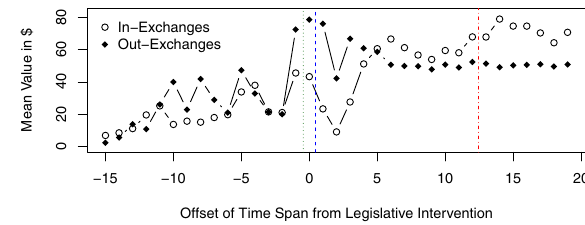
Fig. 11 Mean value per in- and out-exchanges transaction. Temporal representation of the mean value per cash-in transaction (circles) and the mean value per cash-out transaction (diamonds) for 30-day spans. The mean value after the tax-incentive laws (span 0) for in-exchanges transactions is around $64 and the mean value after tax-incentives for out- exchanges is $52.